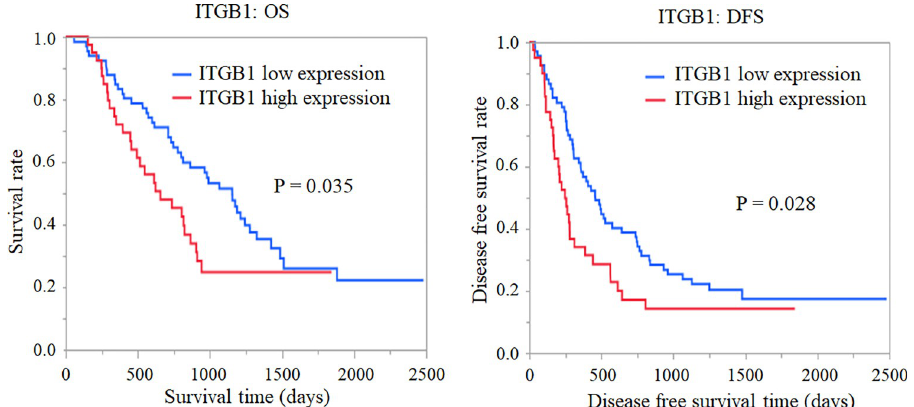
Fig 5. Kaplan–Meier curve for overall survival and recurrence-free survival in ITGB1. We performed immunostaining for ITGB1 in 107 patients diagnosed with PDAC who underwent radical resection without preoperative chemotherapy. Forty cases had an IHC score � 11. The Kaplan–Meier curves for overall and recurrence- free survival are shown. IHC scores � 11 significantly worsened survival time and recurrence-free survival time (p = 0.035,